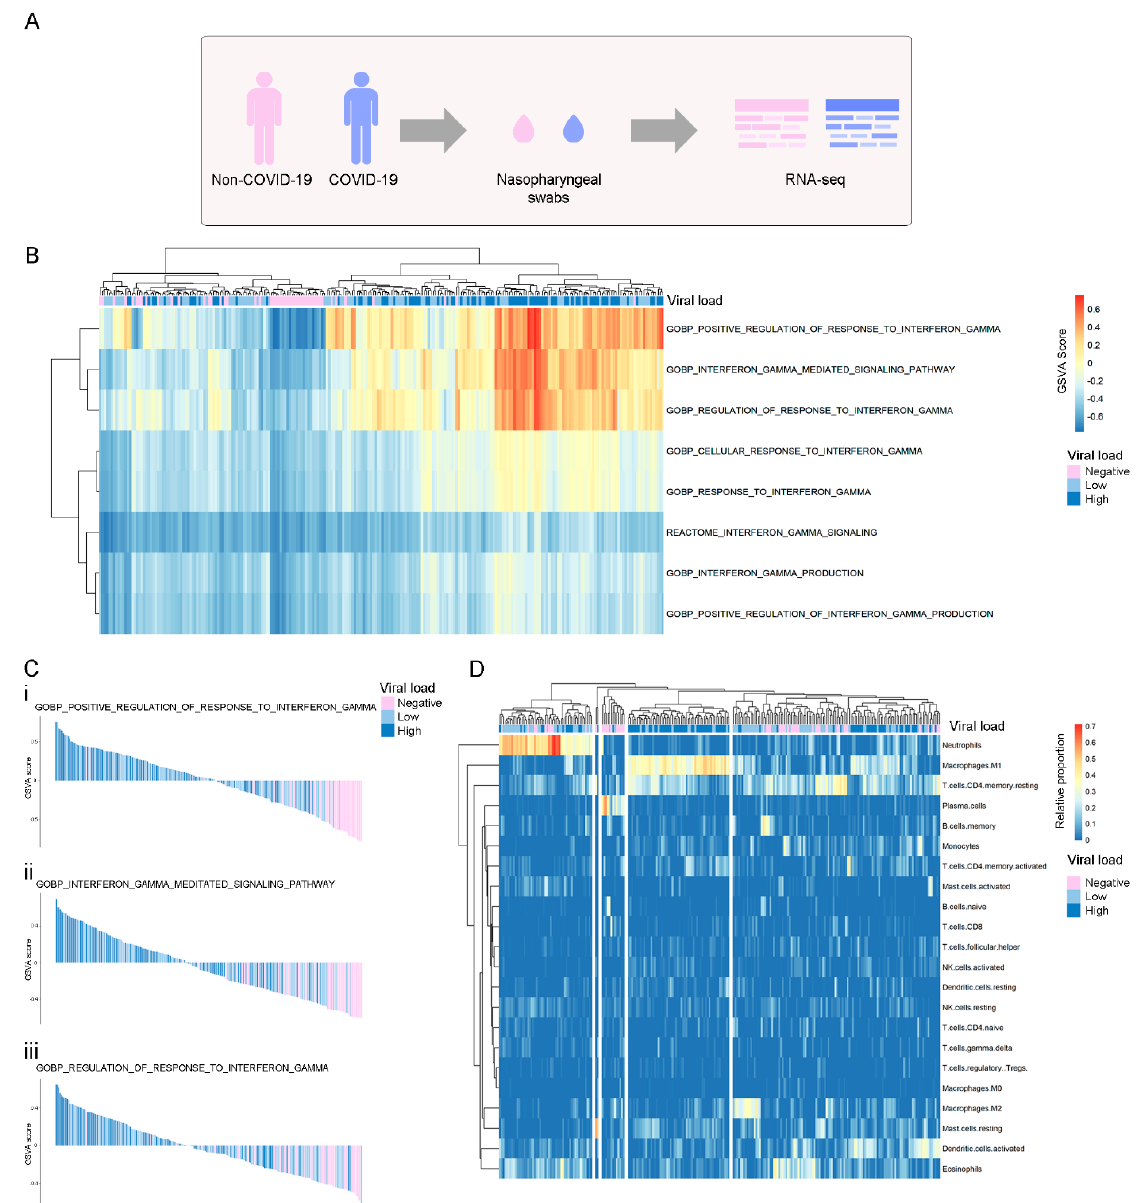
Figure 1. Global assessment at the transcriptional level of pathways and immune cell types related to IFN- γ production, signaling, and regulation of response in COVID-19-positive (light blue and blue) and -negative (pink) patients. ( A ) Experimental design of the GSE152075 dataset, composed of transcriptome data from nasopharyngeal swabs collected from 430 COVID-19 and 54 non-COVID-19 patients. ( B ) Non-supervised clustering of patients according to their GSVA score in each IFN- γ geneset. Higher GSVA scores indicate higher activity of the geneset at the RNA level. Each column is labeled according to the COVID-19 viral load of each patient (negative: pink, low: light blue, high: blue). ( C ) Waterfall plots of selected genesets that were highly activated in COVID-19 patients vs. non-COVID-19 patients. Patients are ordered from the highest to the lowest GSVA score in each geneset. ( D ) Unsupervised clustering of non-COVID-19 and COVID-19 patients according to the relative proportions of immune cell types estimated by CIBERSORT (LM22 signature) in RNA-seq data. Each column is labeled according to the COVID-19 viral load of each patient. Viral load is represented as a color scale and was categorized as Negative (pink), Low (first quartile; light blue), or High (fourth quartile; blue). COVID-19 patients with intermediate viral load were excluded from the